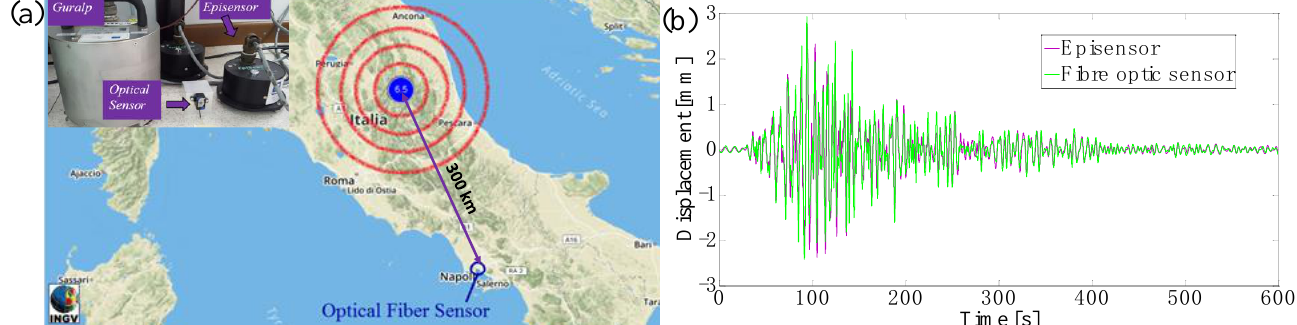
Figure 15. ( a ) Map of the Norcia’s earthquake epicenter. Inset: Picture of optical and reference seismic accelerometers installed at the INGV ( b ) Comparison between displacements recorded by Episensor and by the optical fiber sensor. (Reproduced with permission from ref. [70] (the figure is released under a CC-BY-SA license http://creativecommons.org/licenses/by/4.0/ (https://www.nature.com/articles/s41598-018-25082-8 (accessed on 27 April